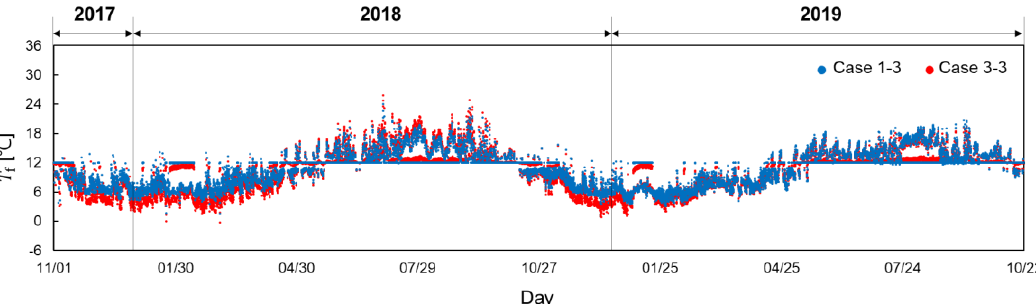
Figure 17. Average temperature variation of the circulating fluid; comparison between the multilayer and single layer for the design parameters. Figure 18. Average temperature variation of the circulating fluid; comparison between the multilayer and the single layer for the design parameters for the borehole depth of 40